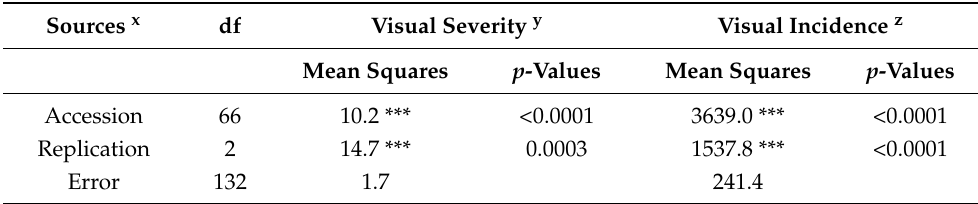
Table 4. ANOVA of visual FBR severity and incidence (%) in mature bulbs of USDA PI accessions evaluated in 2018–2019